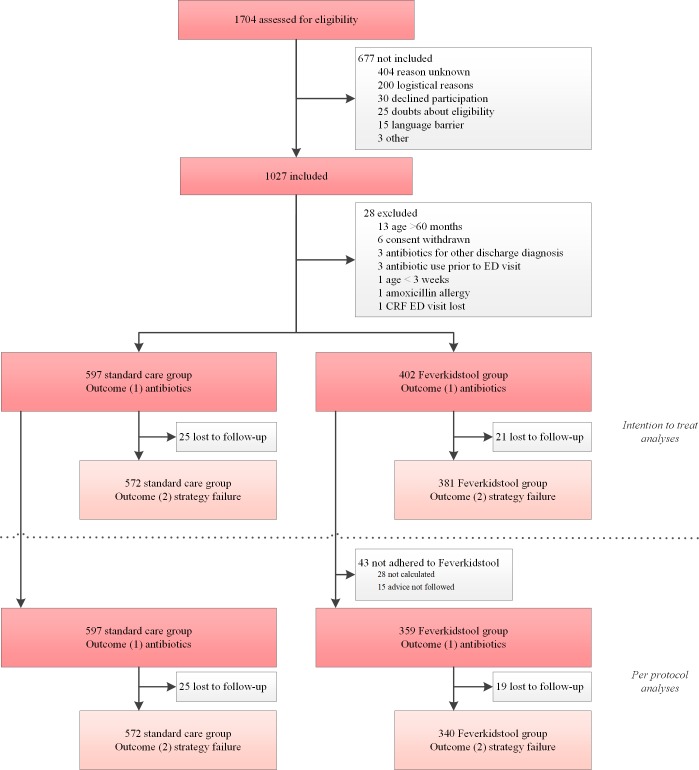
Flowchart of inclusion.CRF, case report form; ED, emergency department.